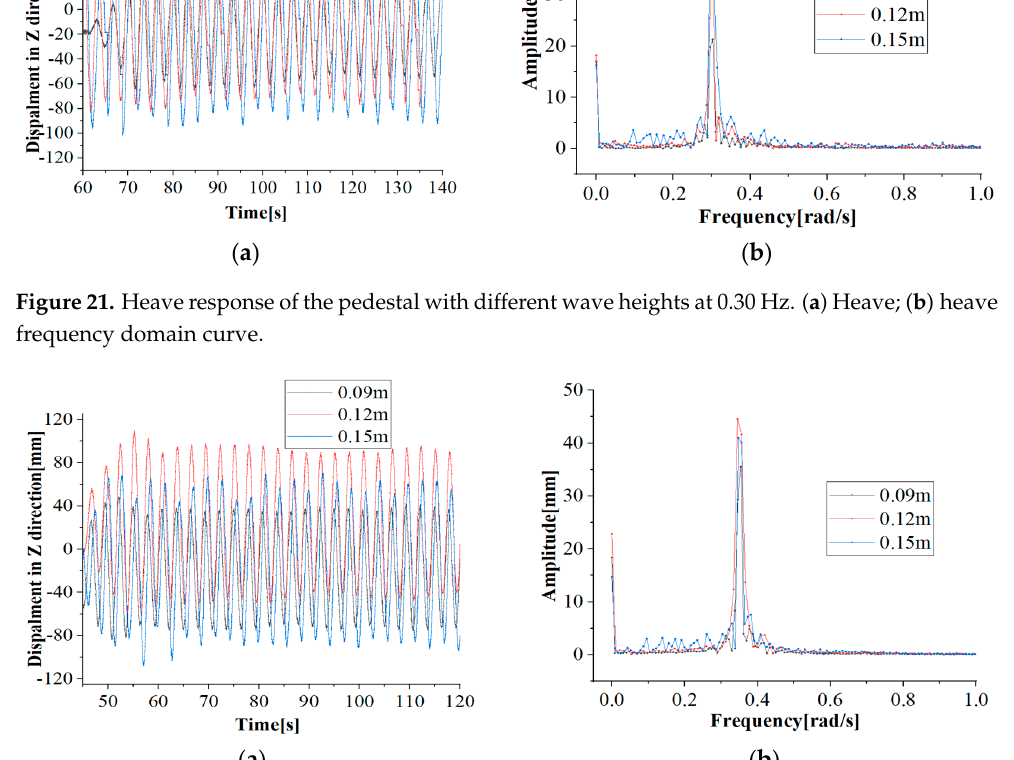
Figure 22. Heave response of the pedestal with different wave heights at 0.35 Hz. ( a ) Heave; ( b ) heave frequency domain curve.